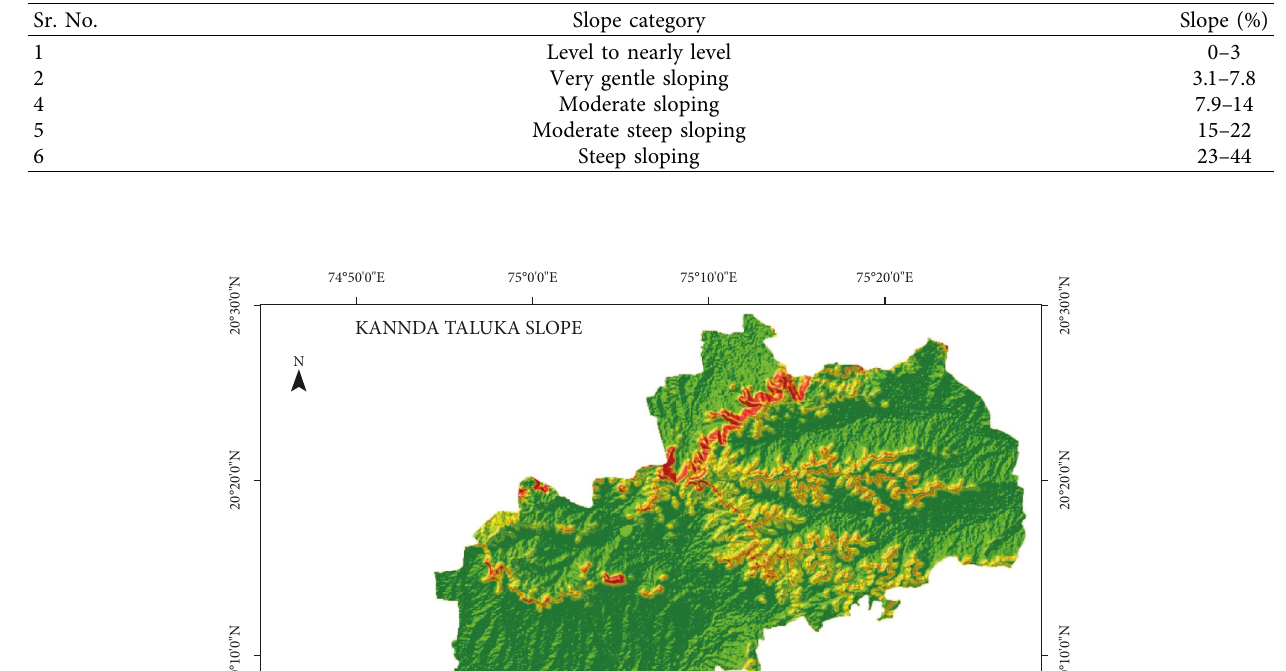
Table 4: Slope classes of the study area.